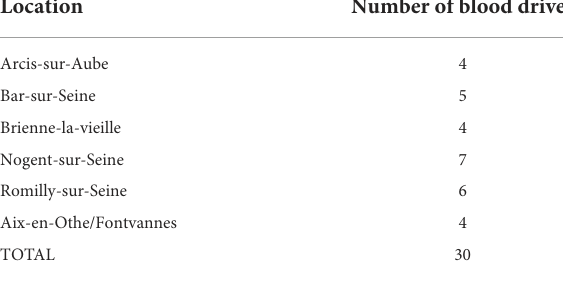
TABLE 1 Summary of the number of blood drives at each of the 6 selected sites during the study period.